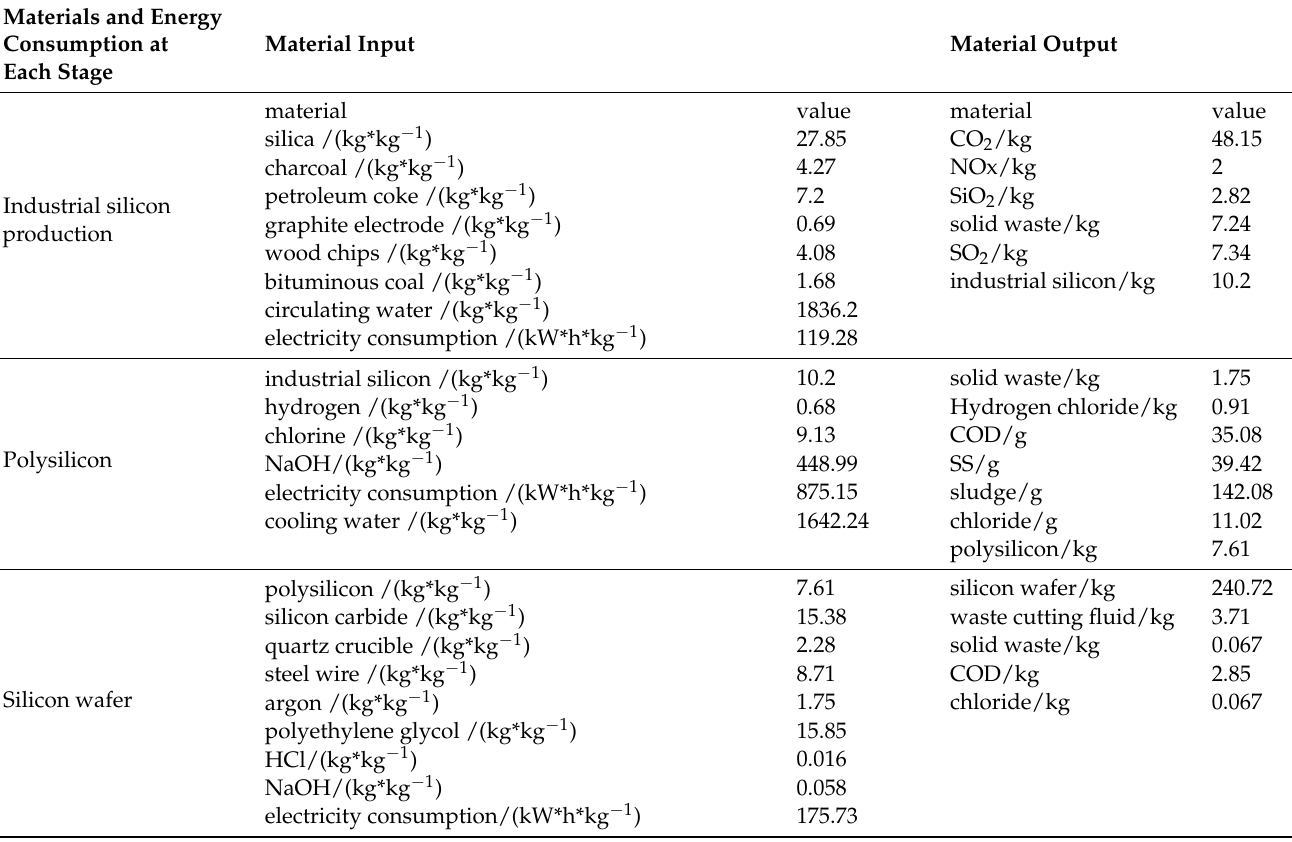
Table 2. Data list of the 1 kWp solar